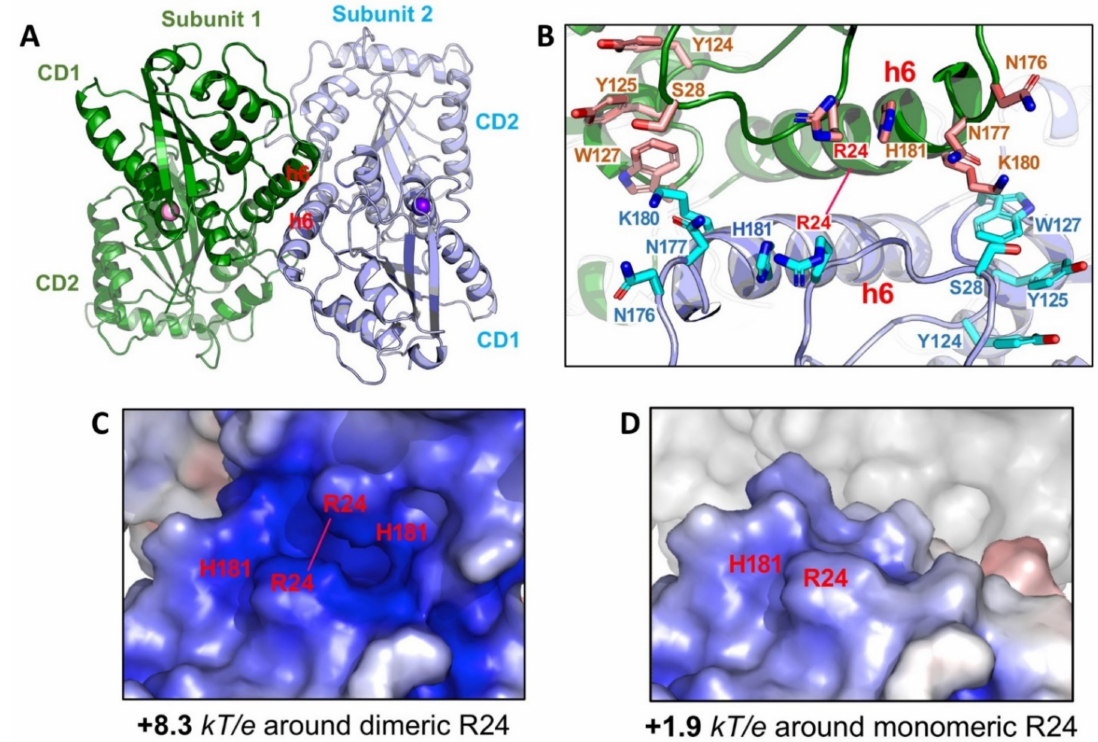
Figure 7. Structure of full-length rA3G. ( A ) The rA3G dimer structure (6P3X). Dimerization is mediated through CD1-CD1 contacts centered around helix 6 (h6) of CD1. ( B ) The positively charged residues centered around R24 on both sides of the dimer junction. Dimerization brings these positively charged residues from each subunit to close proximity. ( C ) The closely positioned charged residues around the dimer junction result in significantly enhanced positively charged electrostatic potentials (PEP or diPEP), as shown by the blue surface (+8.3 kT/e). ( D ) The surface charge potentials of a monomer at the same area around R24, revealing much less positively charged electrostatic potentials (+1.9 kT/e), as compared to those of a